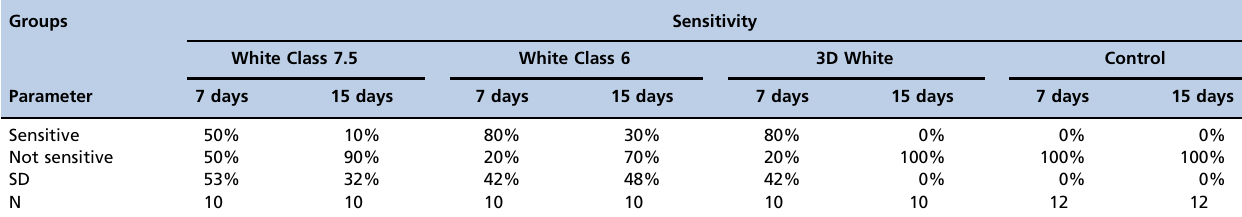
Figure 3 - Discomfort grade of each group range: 0 (no discomfort) to 10 (extreme discomfort). The same letters indicate statistically equal groups. Table 4 - Tooth sensitivity by